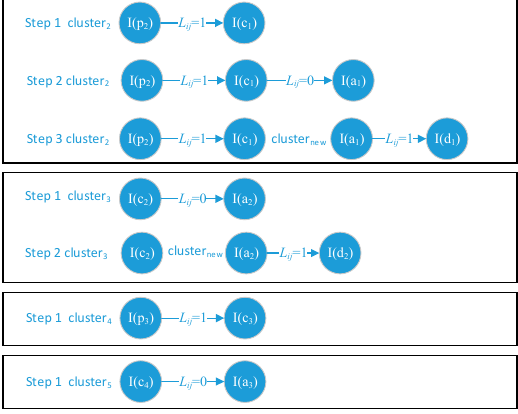
Figure 5. The constructing APT Attack Scenario (AAS) states evolution.